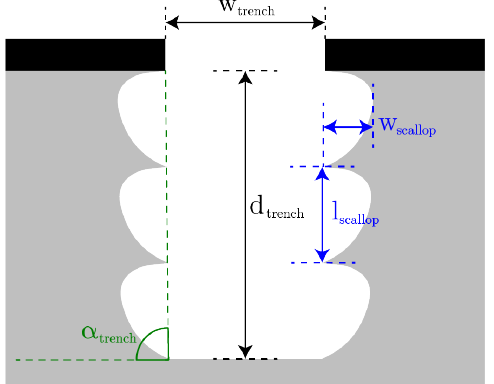
Figure 6. Schematics of an etched trench with a one-to-two ratio in lateral to vertical etching. In this work, the depth and width of the trench, the length and width of the scallop, and the angle of the trench were measured. These are denoted with d trench , w trench , l scallop , w scallop , and α trench ,